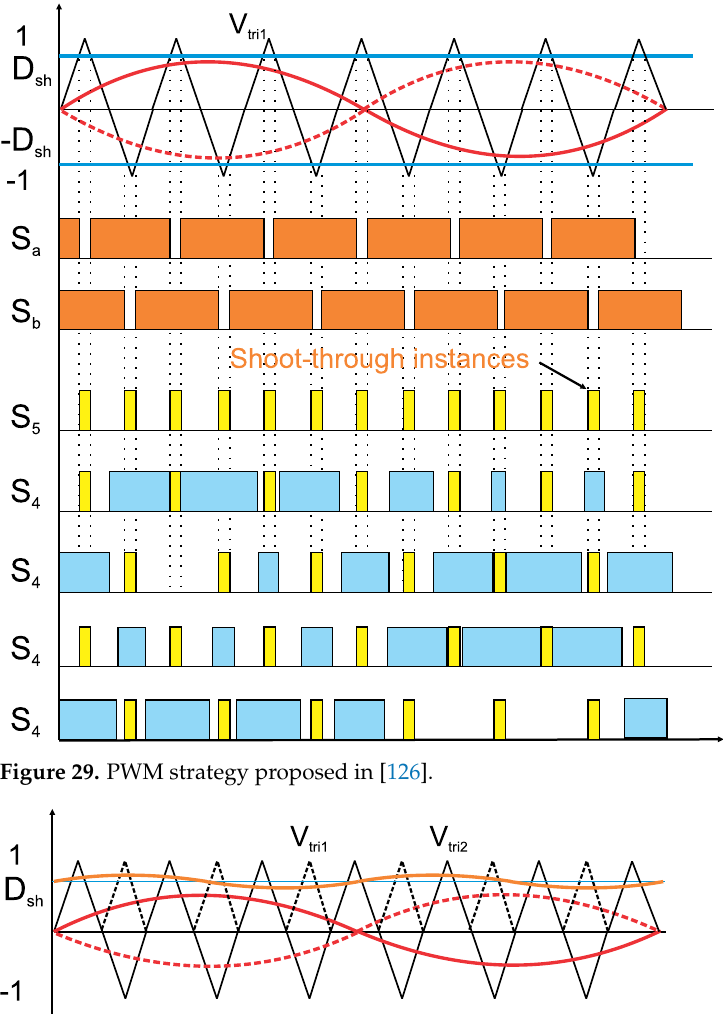
Figure 29. PWM strategy proposed in [126].